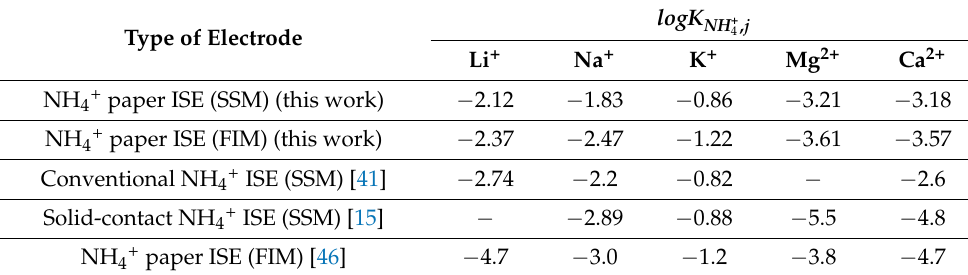
Figure 9. Potentiometric selectivity of the planar ammonium selective electrode obtained by SSM ( a ) and FIM ( b ). Table 2. Potentiometric selectivity coefficients of the prepared planar NH 4 + -ISE based on graphite-PVB solid contact, calculated using methods of separate solutions and fixed interference, compared to the other values reported [15,41,46].